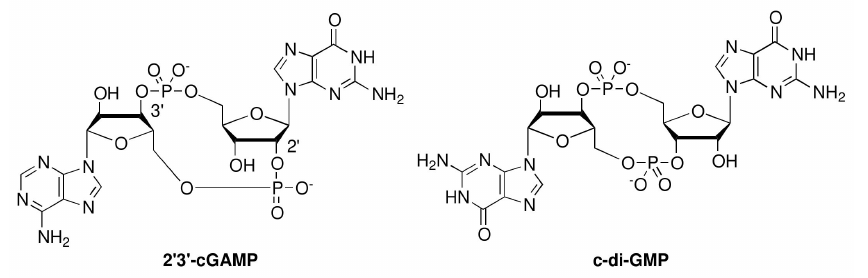
Figure 1. Chemical structures of representative CDNs activating